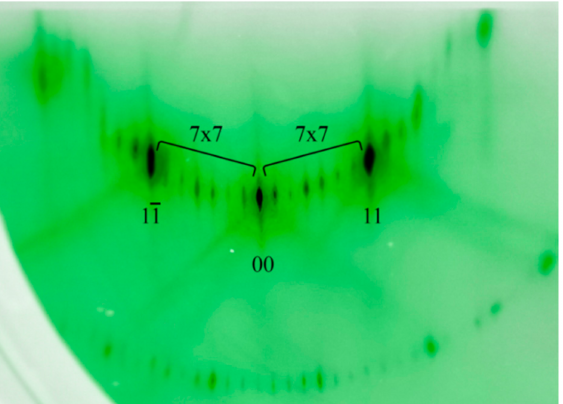
Figure 1. Diffraction pattern from the clean Si(111) surface with the 7 × 7